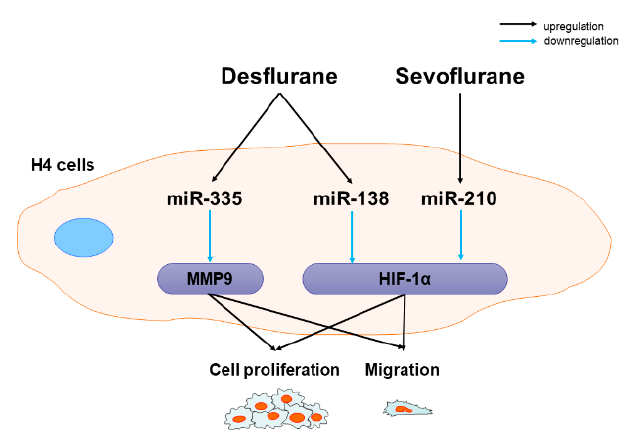
Figure 6. Inhalational anesthetics attenuated neuroglioma (H4) cell malignancy via upregulation of anticancer miRNA expressions. Sevoflurane exposure to H4 cells decrease H4 cell proliferation and migration via HIF-1 α by miR-210 upregulation. Desflurane exposure to H4 cells decrease H4 cell proliferation and migration via HIF-1 α and MMP9 by miR-138 and miR-335 upregulation, respectively.